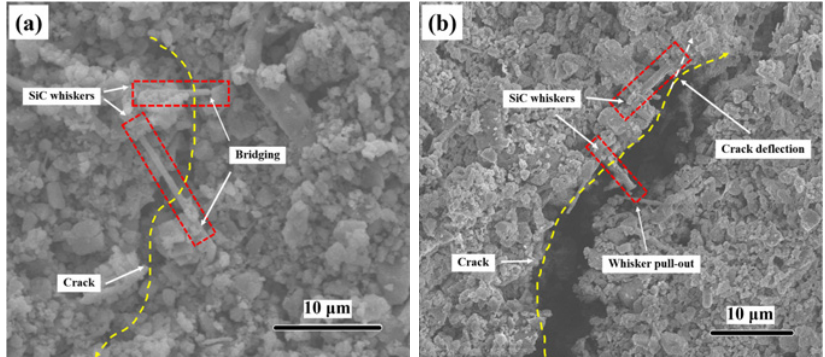
Fig. 10 SiC whisker toughening mechanism for the SM middle coating: (a) bridging of SiC whisker; (b) crack deflection and SiC whisker